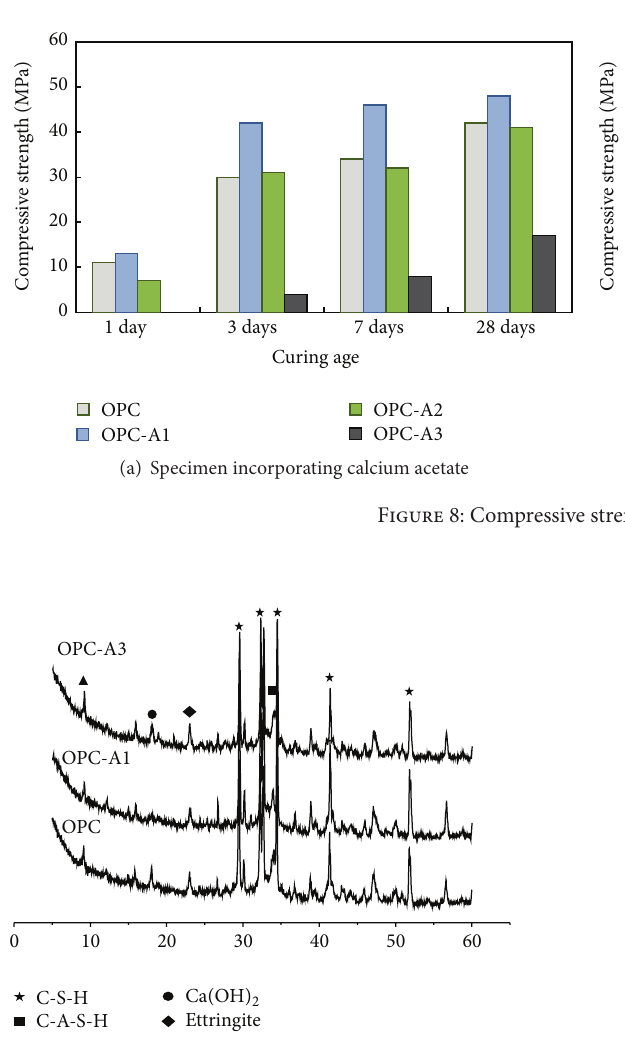
Figure 9: Specimen incorporating calcium acetate (1 day).